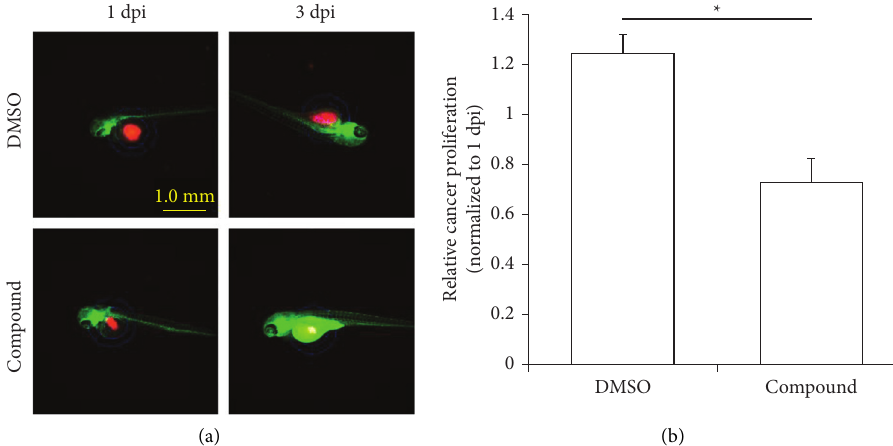
Figure 6: Selective inhibition of CSCs in vivo . (a) Representative images of the ALDH(+) K562-KOr cell zebrafish xenograft (1 dpi and 3 dpi; dpi, day postinjection) before and after 1 μ M compound exposure for 48h. (b) Quantification of ALDH(+) K562-KOr cells in the zebrafish xenograft (3 dpi normalized to 1 dpi) about the anticancer effects of 1 μ M compound exposure for 48h. ∗ P < 0 . 05 and n � 4.